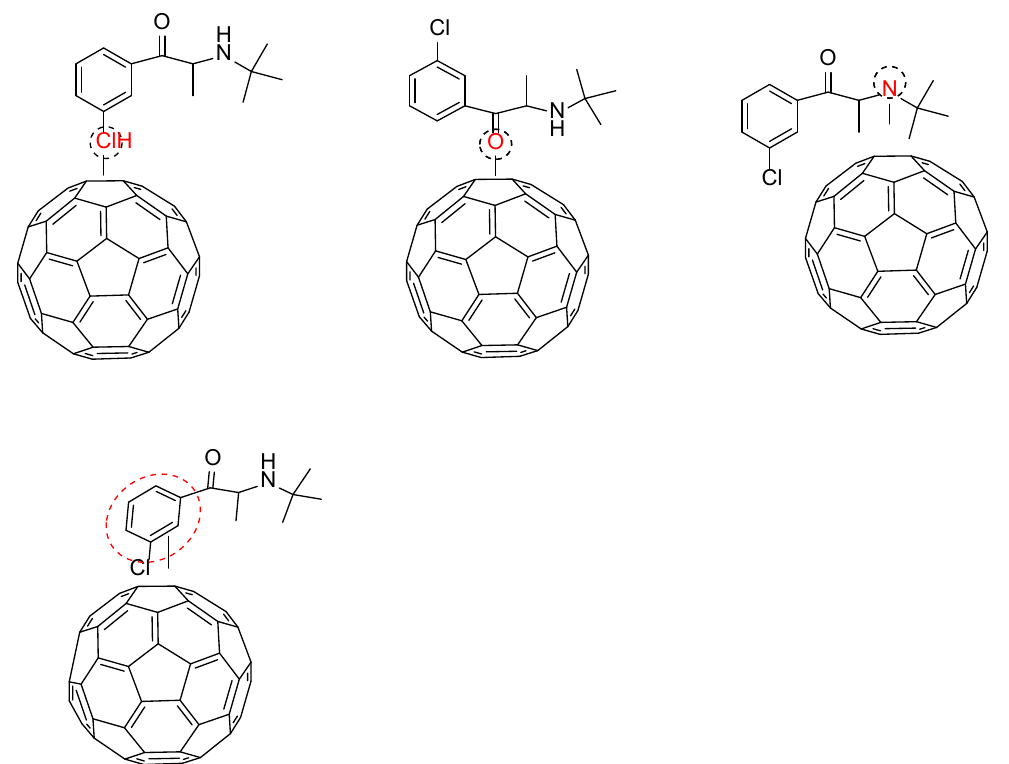
Fig. 3. Bupropion -C60 complexes in different active sides (four different positions)